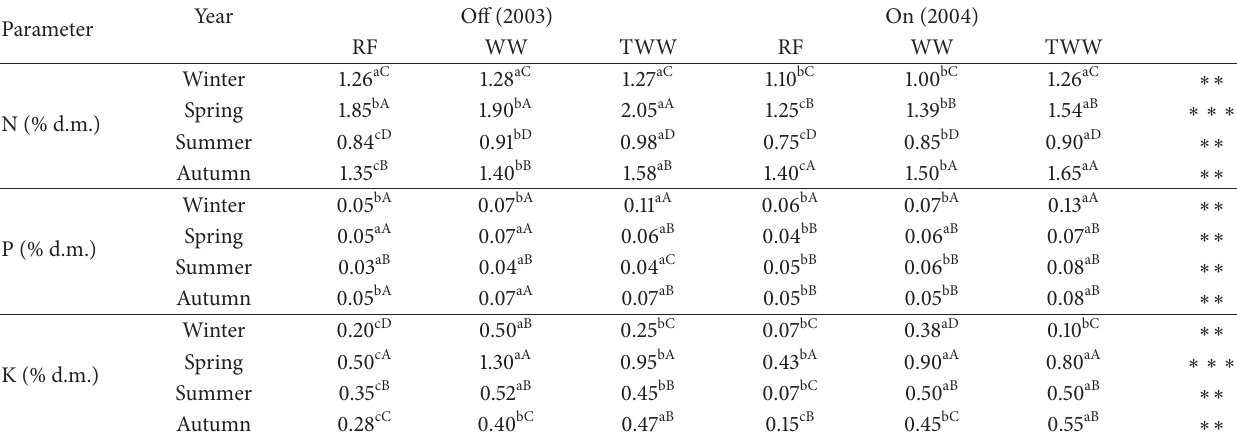
Autumn 0.28 cC 0.40